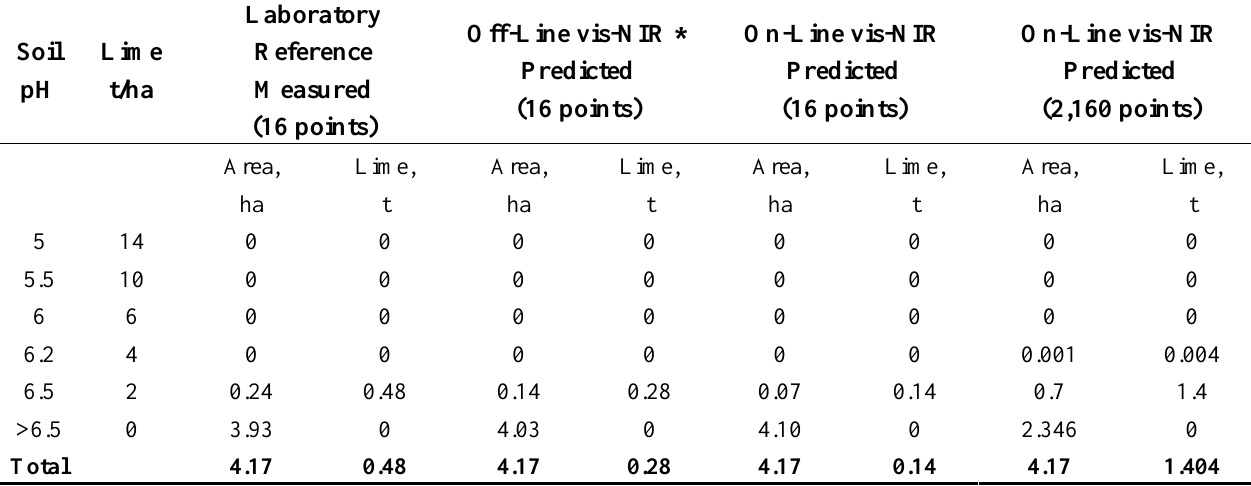
Table 5. Lime requirement calculated for different scenarios of pH estimation method. Soil pH